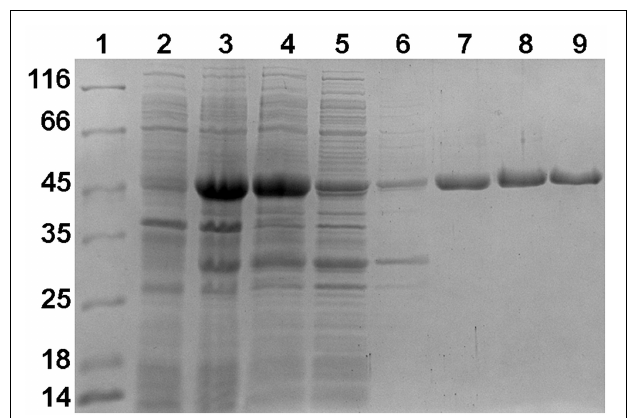
FIGURE 2 | SDS-PAGE (12.5%) of fractions obtained during purification of heterologously produced Nmar_1028. Lane 1, molecular-weight markers (labeled in kDa); lane 2, cells before induction; lane 3, cells after induction; lane 4, cell extract; lane 5, flowthrough from Ni-NTA column; lane 6, wash with 50 mM imidazole; lane 7, elution with 500 mM imidazole; lane 8, the first peak during gel filtration; lane 9, the second peak during gel